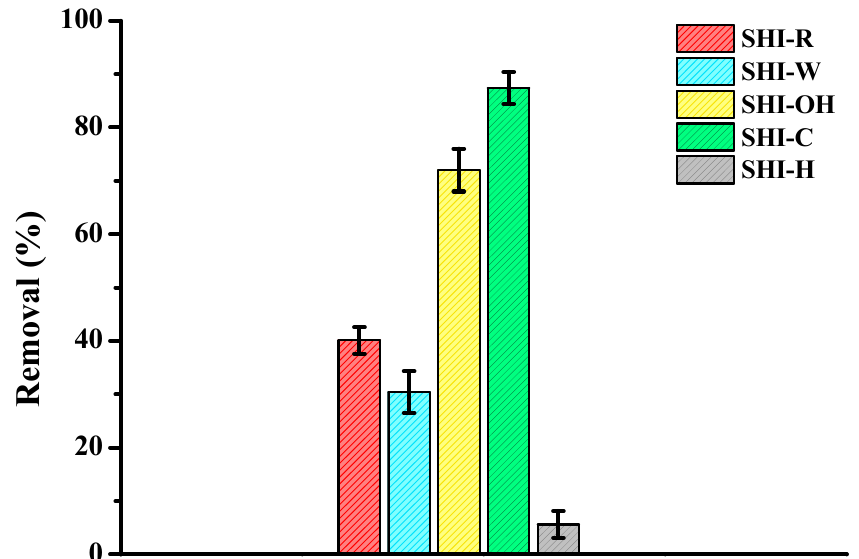
Figure 9. Comparison between removal (in %) of copper by hemp shive samples from an aqueous solution using an initial metal concentration of 200 mg/L (other conditions: 2 g of sample in 100 mL of solution; contact time = 2 h; agitation speed = 250 rpm; temperature 20 ± 1 °C; n = 5).